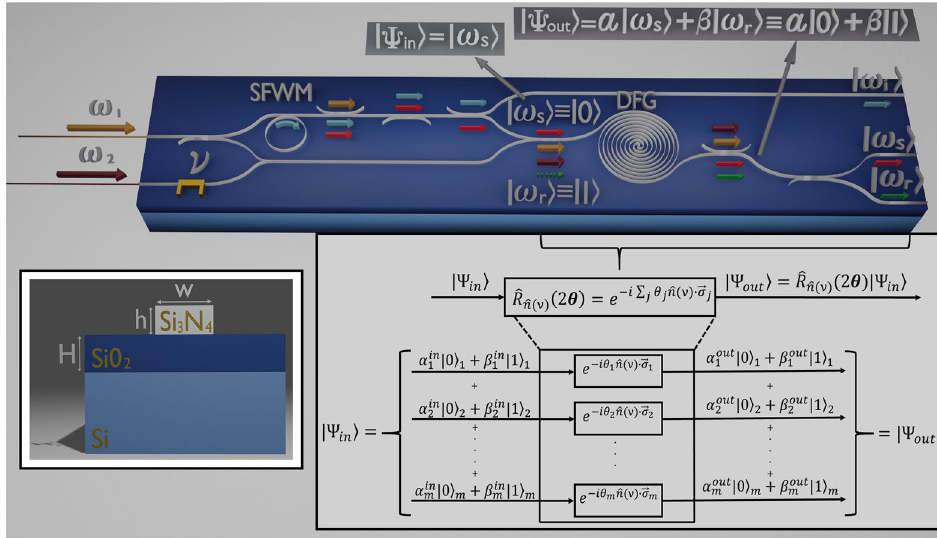
Figure 1. Design of the proposed integrated photonic circuit for color qubit preparation and rotations. All components in the device are based on silicon nitride (Si 3 N 4 ) waveguides above a substrate of silicon dioxide (SiO 2 ) on silicon (Si). The top scheme describes the circuit operation, comprising the stage for generating a heralded single-photon state, which acts as input to the quantum gate waveguide (the second stage), where the DFG process occurs. The bottom-right scheme depicts the DFG process that leads to a generalized rotation operator for single-qubits defined in the temporal mode basis. Note that a computational basis in pairs of temporal modes. The bottom-left image is a representation of the waveguide’s